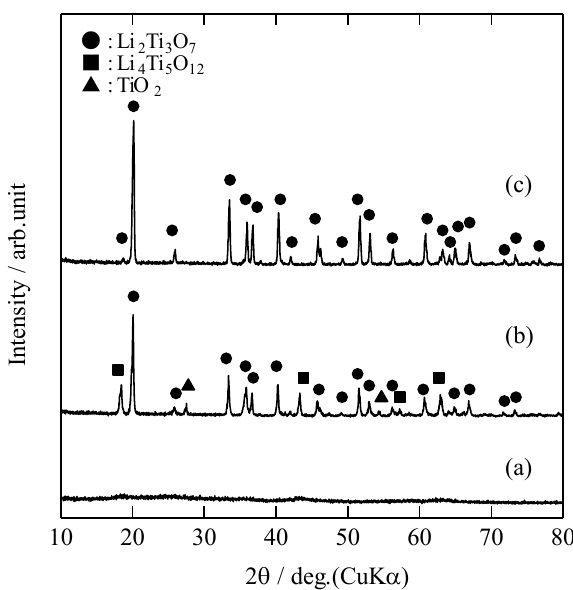
Figure 3. XRD pattern of ( a ) as-prepared powders and RLTO powders calcined under argon/hydrogen; at ( b ) 800  C; and ( c ) 1000 